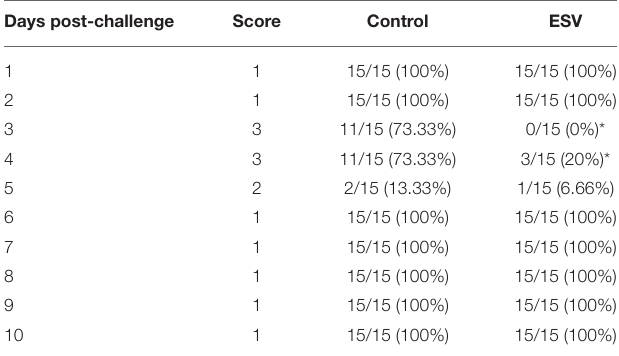
Experiment 3. Data are expressed as the number of piglets with diarrhea score/number of piglets in the group (%). Diarrhea score: 1, well-formed feces; 2, mild diarrhea; 3, severe diarrhea. * Asterisk within rows indicates a significant difference at P < 0.001.